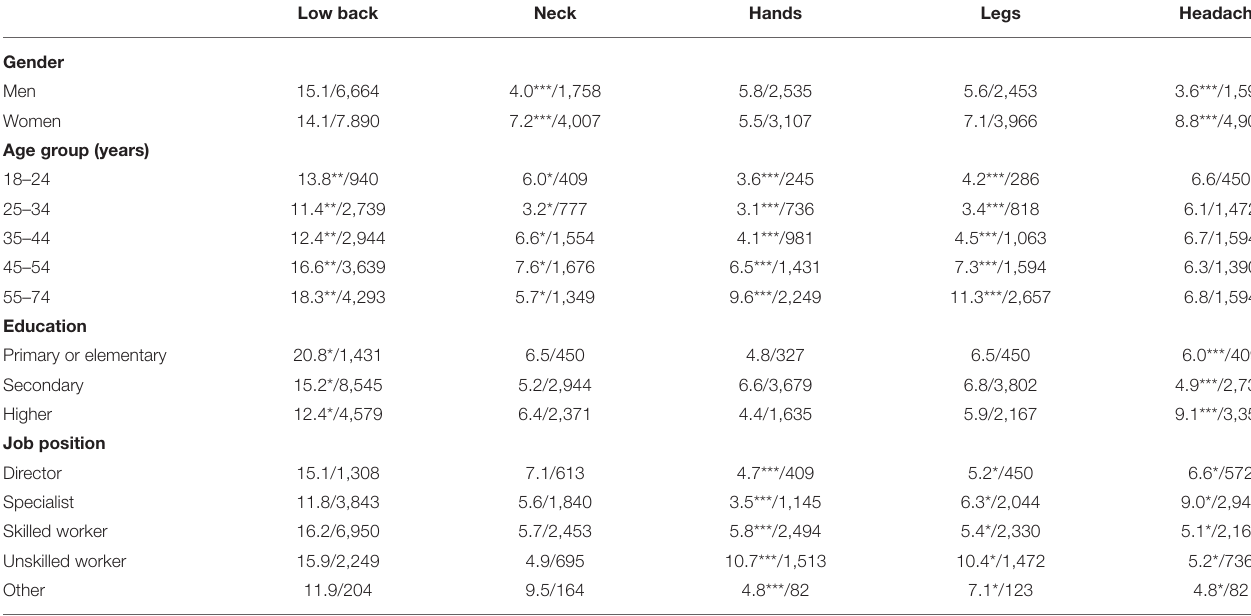
TABLE 1 | Prevalence of self-reported pain at different locations lasting longer than 3 days in the last year, by sociodemographic group (percentage/number per 100,000